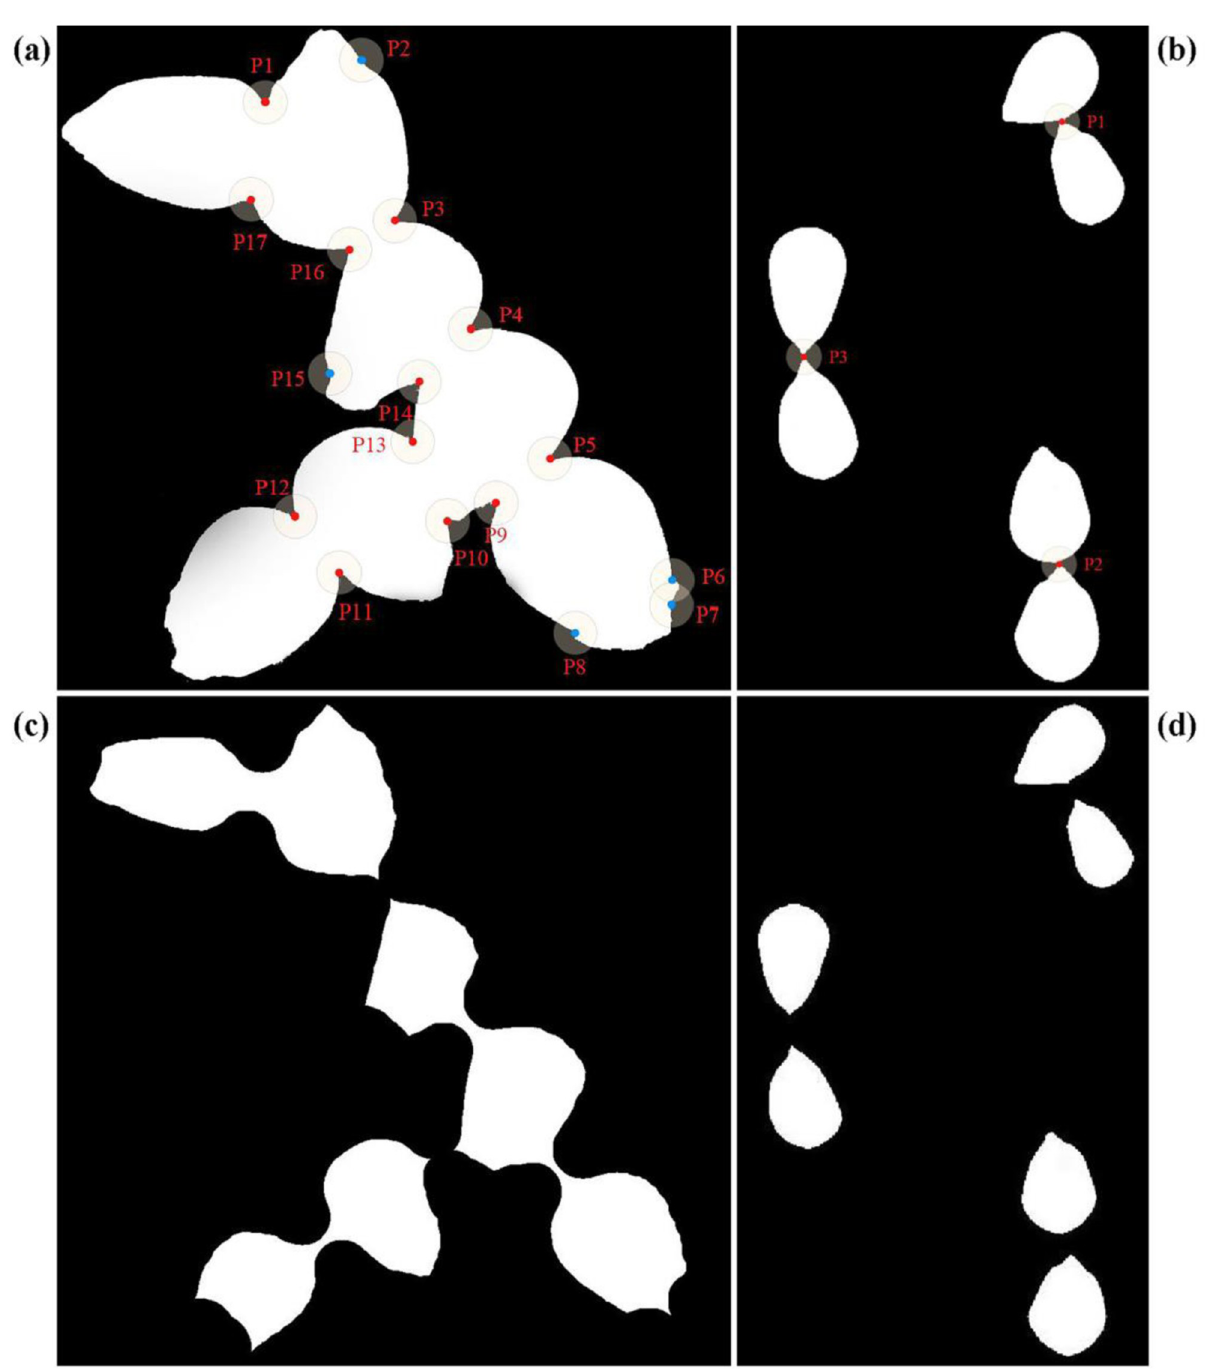
Fig 13. Adhesion area analysis. Note The distribution of grain corner points and the number of corner points under special position. C and D are the results of applying the algorithm of this paper to the two cases of A and B, respectively.